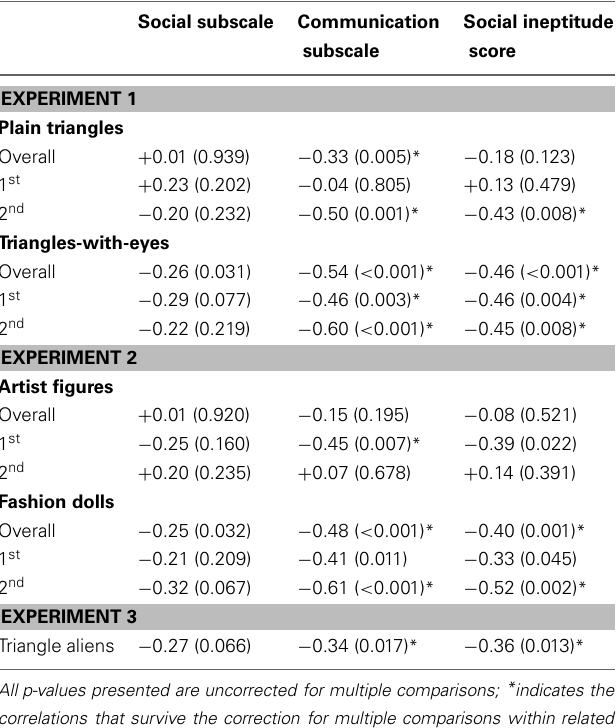
Table 1 | Summary of correlations (and p -values) between the relevant social skill scores and each condition, overall and by order of conditions where relevant.